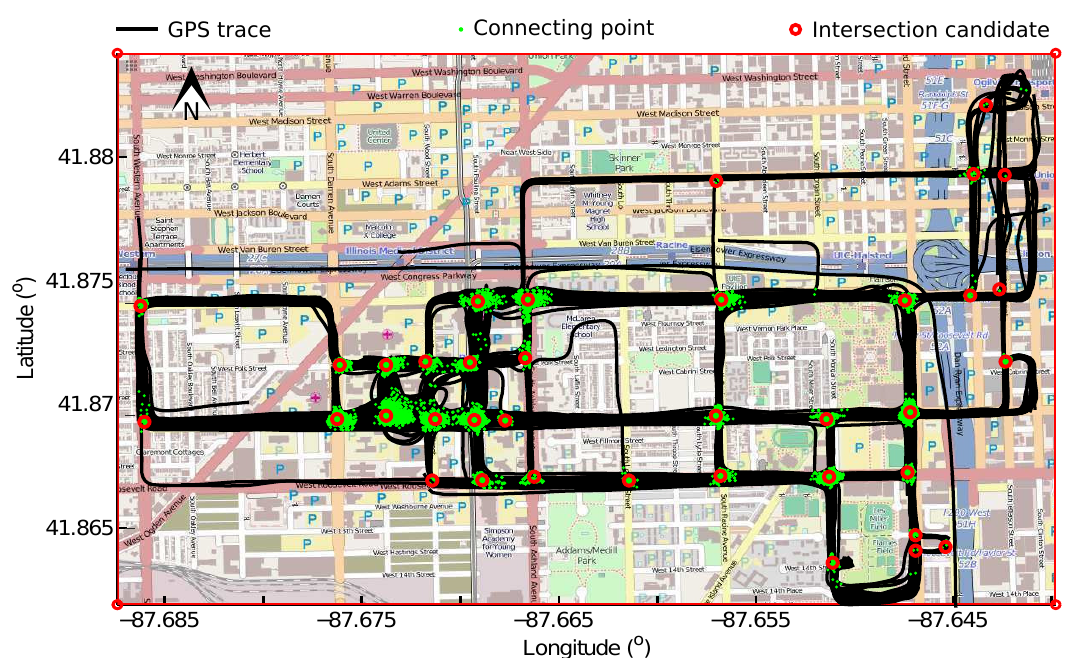
Figure 9. Intersection candidates. The connecting points are depicted using green dots, and 37 intersection candidates using red circles.